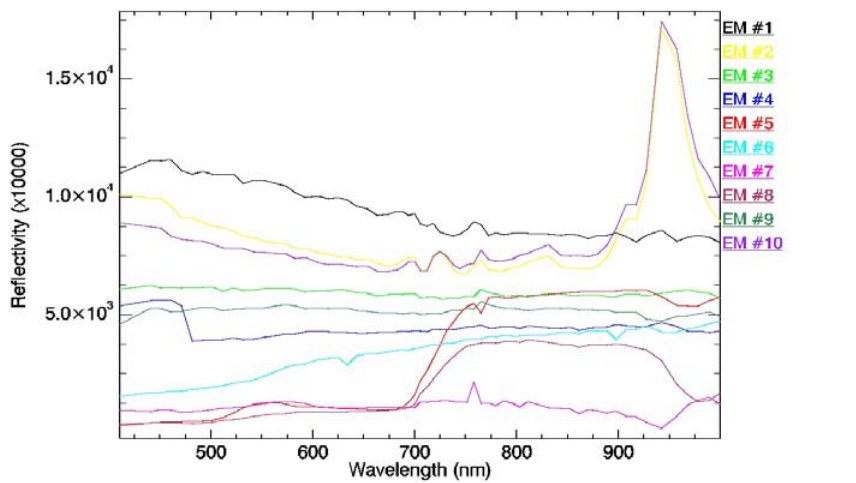
Figure 13. Reflectivity spectra for the endmembers extracted from the image using the